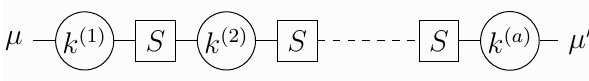
Figure 9 . A single chain of T (SU( N )) theories coupled by N = 3 Chern-Simons multiplets.